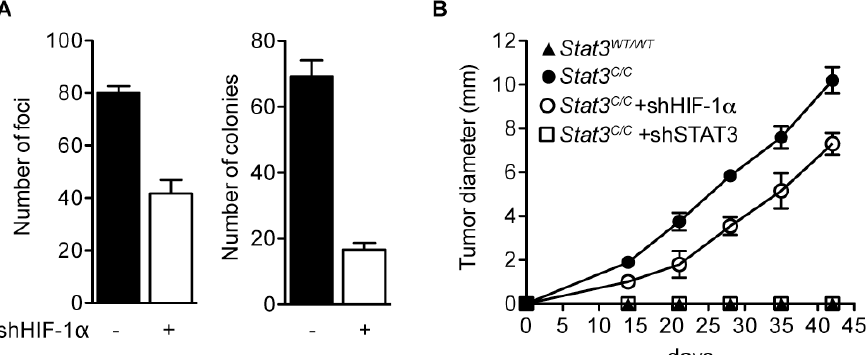
Figure 5. Immortalized Stat3 C/C MEFs were silenced (white bars) or not (black bars) for Hif -1 α and their ability to form foci and colonies in soft agar was measured ( A ). Immortalized MEFs of the indicated genotypes and treatments were tested for their ability to grow in vivo in nude mice ( B ). Bars represent mean values ± SEM of three independent experiments. Modified from reference [24], according to the journal’s license